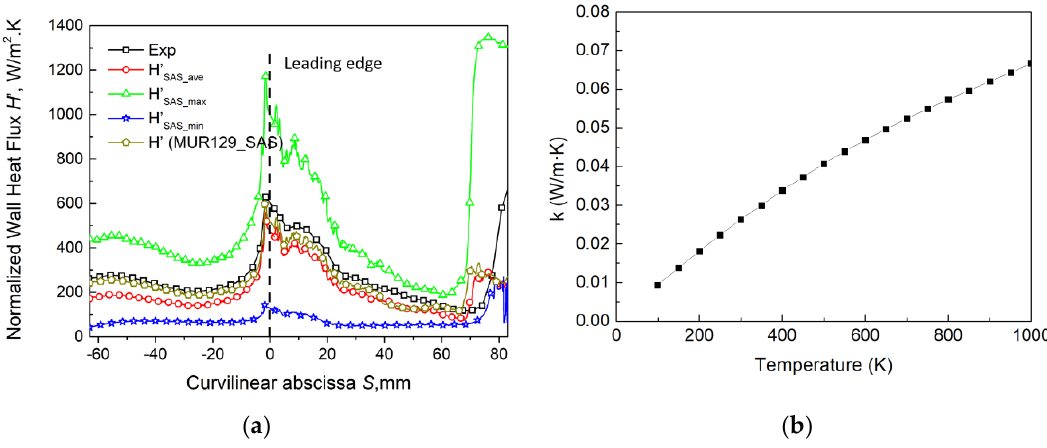
Figure 10. Influence of the entropy wave on the wall heat transfer ( a ) and the variation of air thermal conductivity ( b ) with temperature.